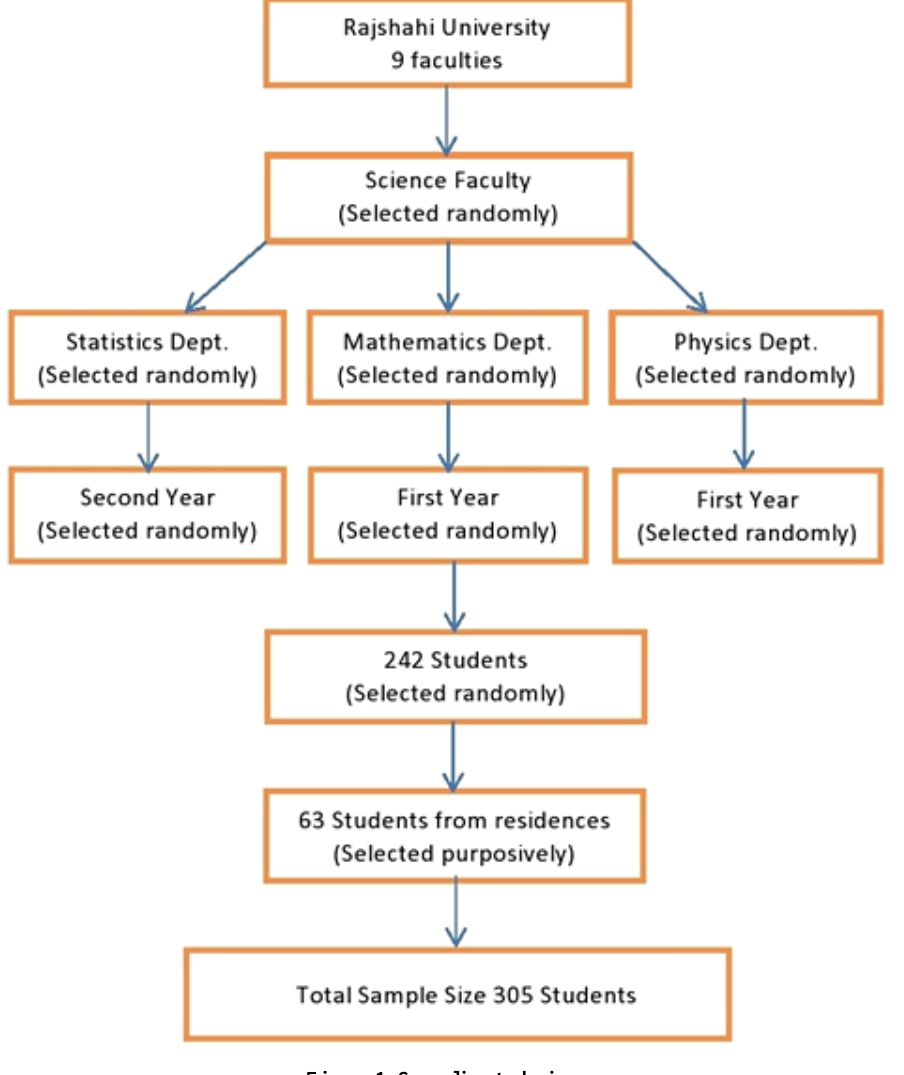
Figure 1. Sampling